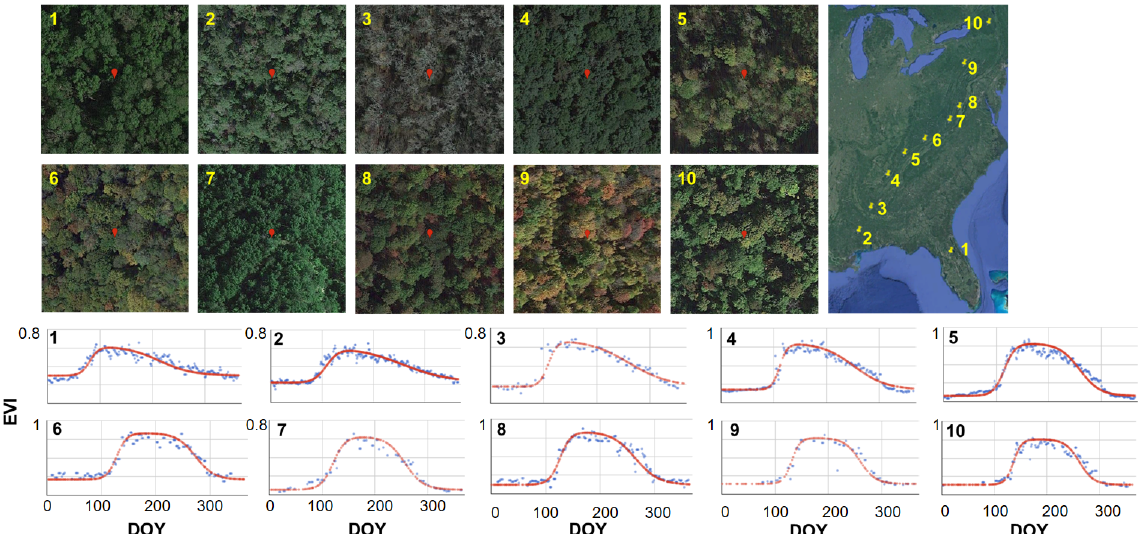
Figure 4. Performance of the Google Earth Engine (GEE)-based double logistic model from the south to the north in the United States using forest as an example. Each snapshot indicates a 1km 2 square, and the red dot in the middle is the location (30m) of the enhanced vegetation index (EVI) time series fitting.